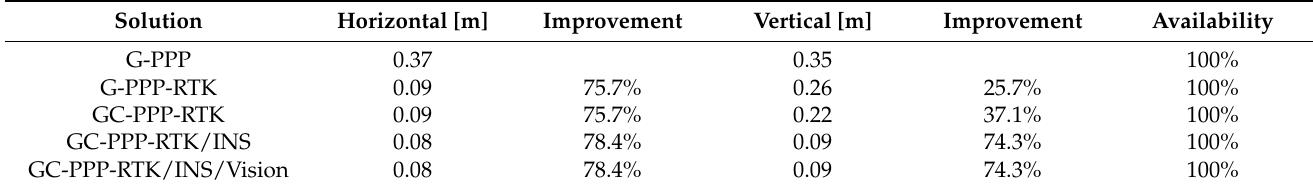
Table 3. RMS of the positioning error of T01 in horizontal and vertical directions, respectively.